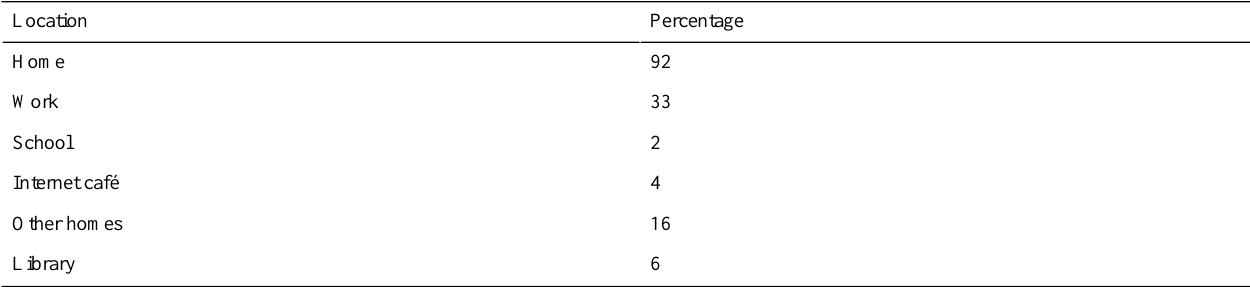
Table 4. Locations where participants have Internet